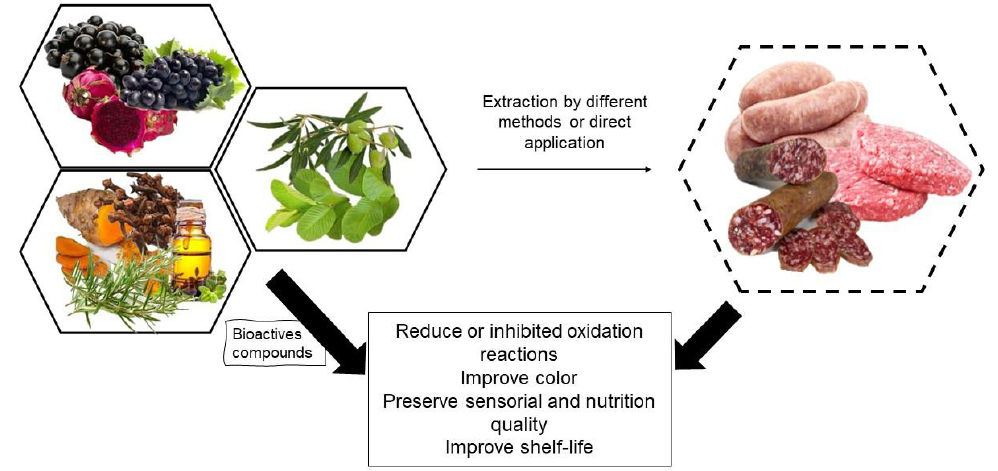
Figure 1. Illustration representing the application of natural sources as an antioxidant in meat products as a means of preserving quality and shelf-life. products as a means of preserving quality and